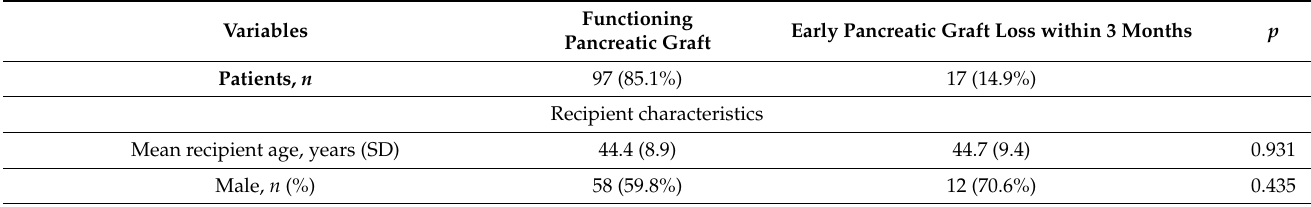
Table 1. Recipient and donor